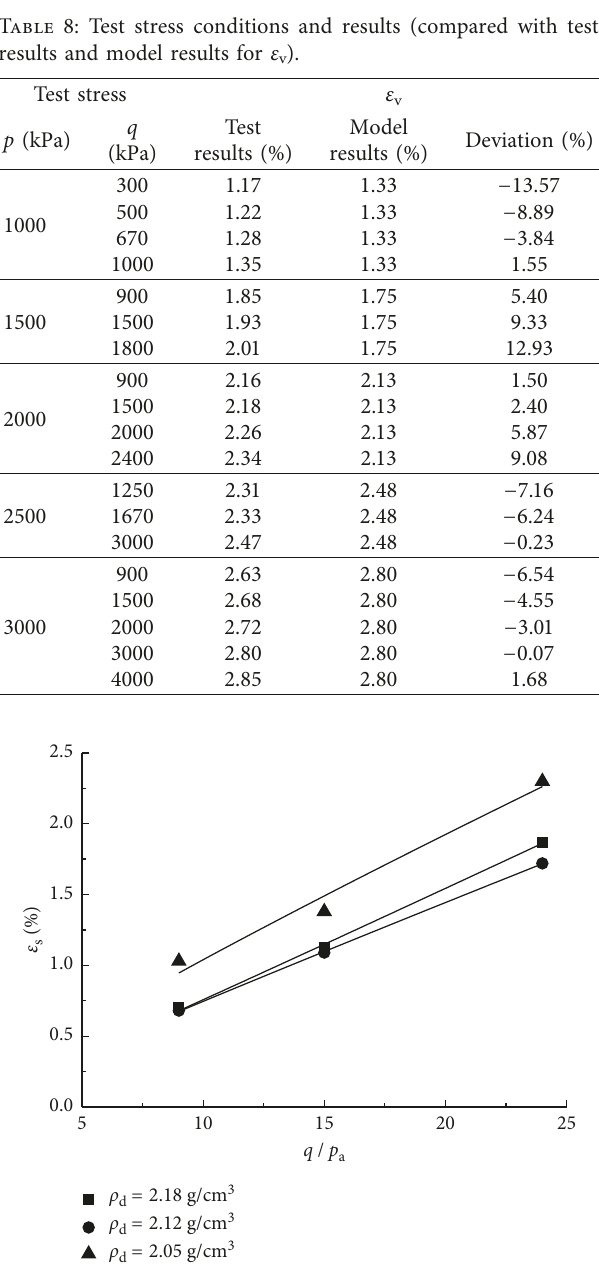
Figure 11: q / p a versus ε s curve (different sample dry density conditions).